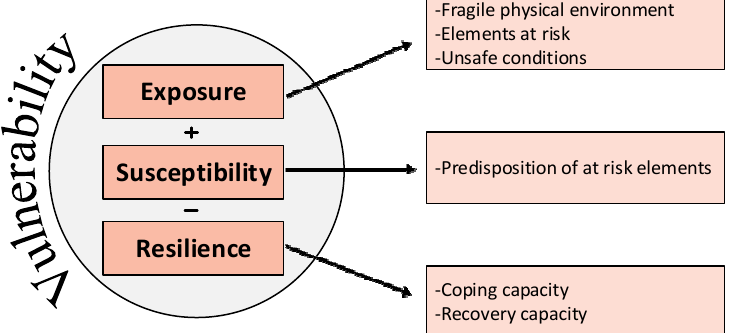
Figure 4. Social vulnerability components.